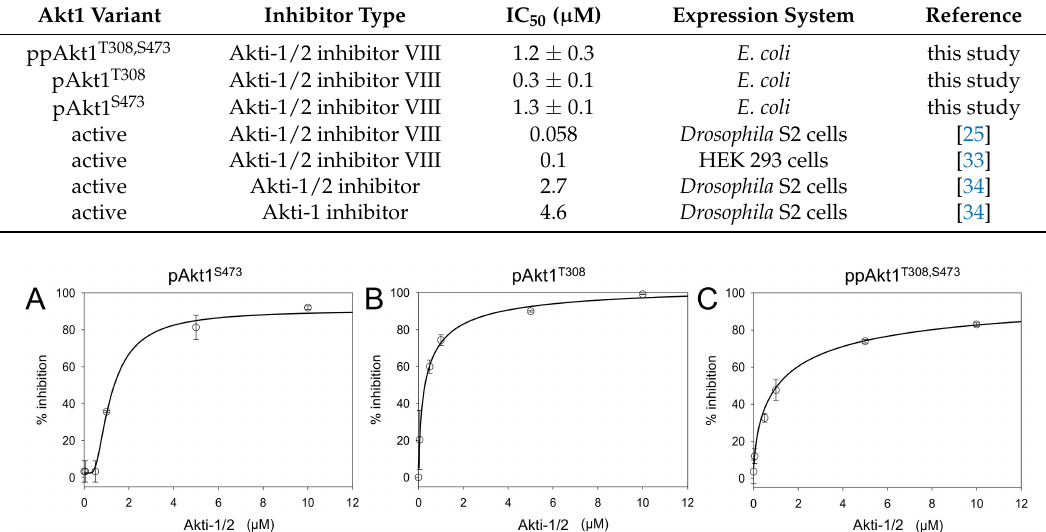
Table 4. Akti-1/2 inhibitor half maximal inhibitory concentration (IC 50 ) for pAkt1 variants.